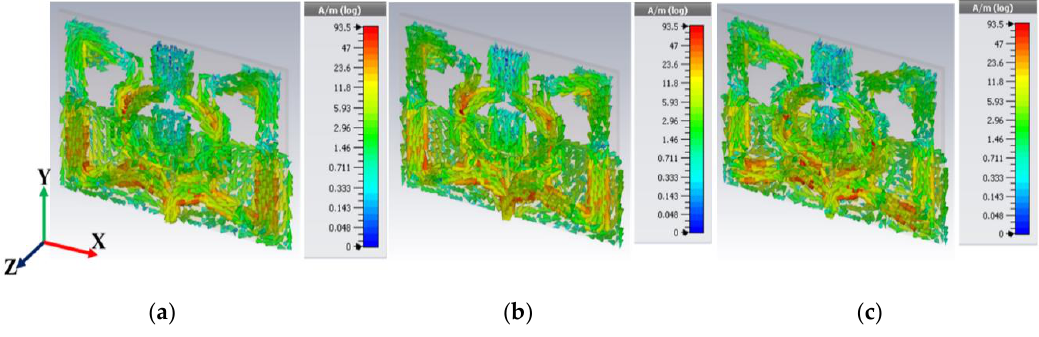
Figure 7. Surface current distribution of the proposed antenna at 4, 4.27, and 4.4 GHz ( a–c respectively).